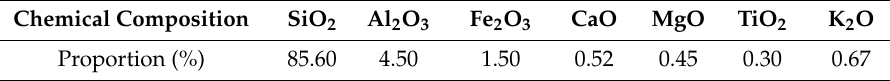
Table 2. Diatomite chemical composition.